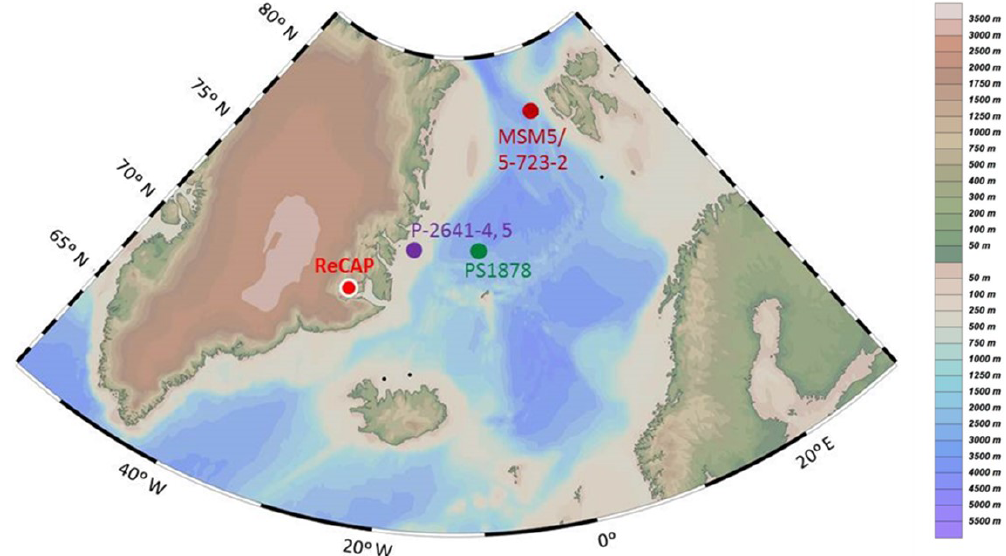
Figure 1. Location of the ReCAP ice core (red) and other marine paleoceanographic archives in the Nordic Seas discussed in the text. For references of the paleoenvironmental proxies from the displayed sediment cores, please refer to the text and the caption of Fig. 2. Core PS1878 (Telesi´nski et al., 2015); Core PS2641-4 (Müller et al., 2012); Core MSM5 5/723-2 (Werner et al., 2013, 2016). Bathymetric map obtained from Ocean Data View software (Schlitzer, 2015). Bathymetry is shown in the color